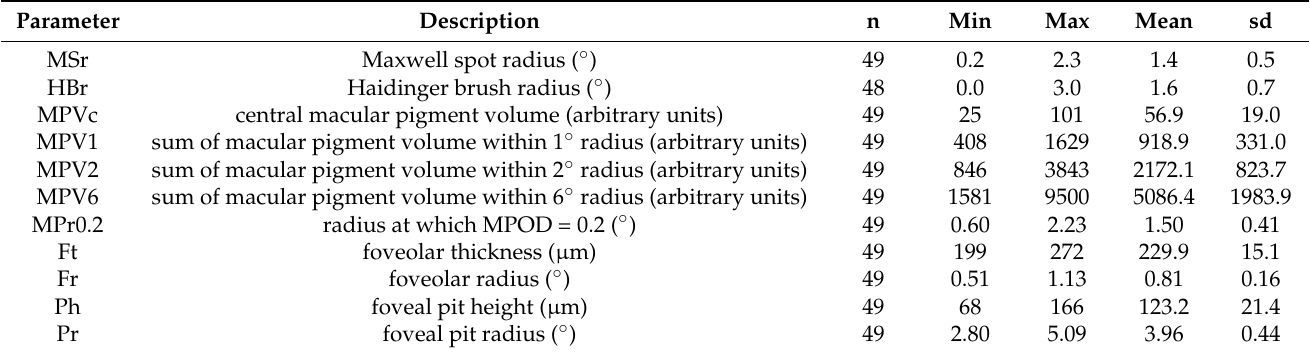
Figure 1. Machine − generated output of macular pigment optical density distribution analysis for case 16 (category 2; central peak and ring). The right image is a digital subtraction of green − and blue − light autofluorescence data, centred on the foveola (intersection of yellow axes) with 1 ◦ (red), 2 ◦ (blue) and 6 ◦ (green) radius circles. Top left is a graph of MPOD (vertical axis) along circular paths of radii given on the horizontal axis. The blue zone spans the maximum and minimum optical density at the given radius, the green zone spans the standard deviation and the continuous black curve is the mean optical density at this radius. The black dashed horizontal/vertical lines indicate the measurement of the radius at which the mean macular pigment optical density has a value of 0.2 (MPr0.2). The table shows data for 1 ◦ (red), 2 ◦ (blue) and 6 ◦ (green) circular paths. In all cases the 6 ◦ path is taken as the zero datum for optical density. Red, blue and green boxes indicate sum of macular pigment volume within 1 ◦ (MPV1), 2 ◦ (MPV2) and 6 ◦ (MPV6) radii, respectively (see Table 1). Table 1. Measured parameters: definitions and basic statistics for all cases (i.e., sum of all three categories).